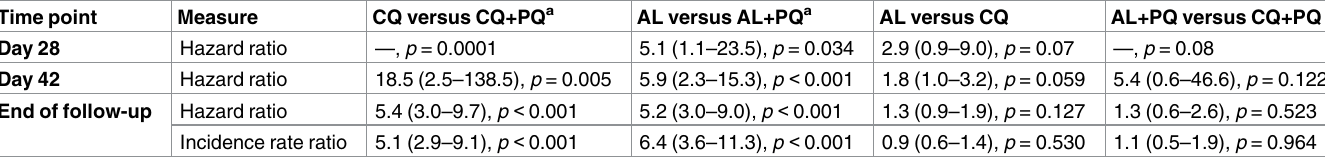
Table 3. Hazard ratios and incidence rate